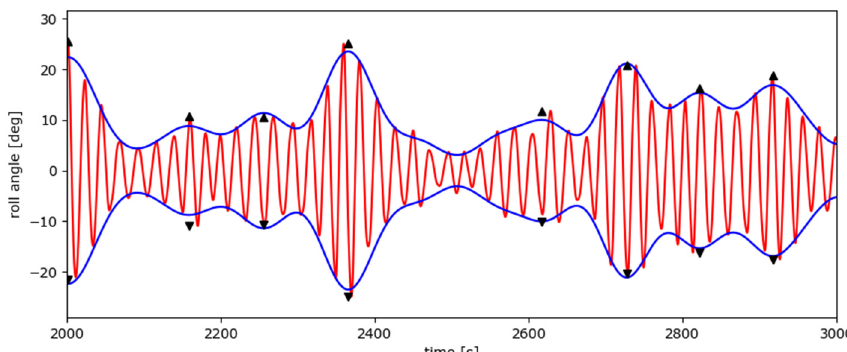
Figure 2. Visualisation of the analysis procedure of parametric roll events: plot of the roll motion (red line) and the envelope (blue lines), with the peak of each event in the interval defined by Equation (4), (black symbols).